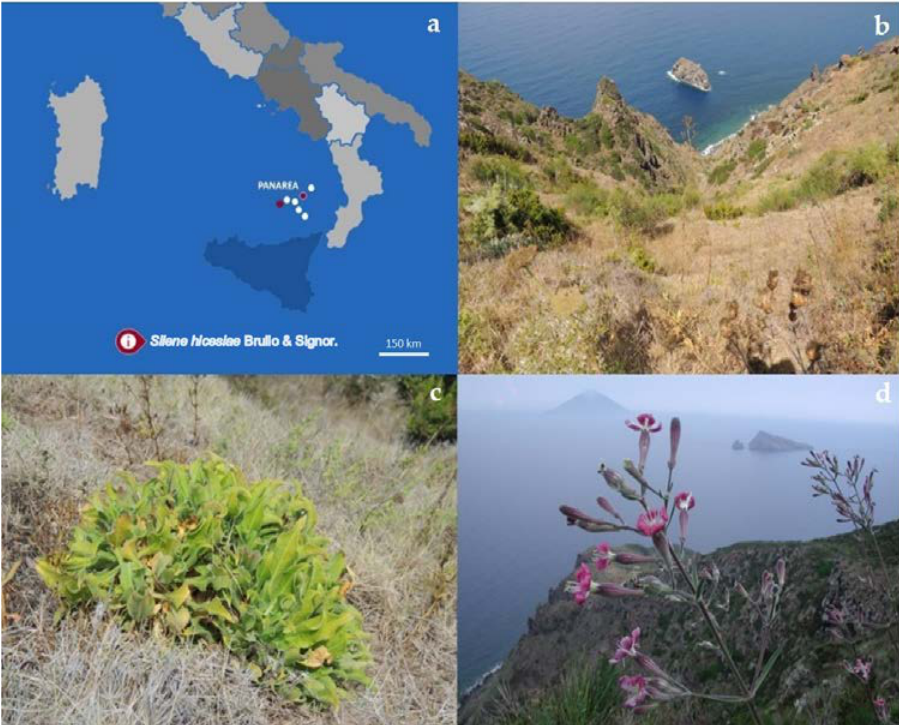
Figure 1. ( a ) Map of the geographic range of S. hicesiae (Aeolian Archipelago—Southern Italy); ( b ) growth site in Panarea; ( c ) basal rosette; ( d ) inflorescence.